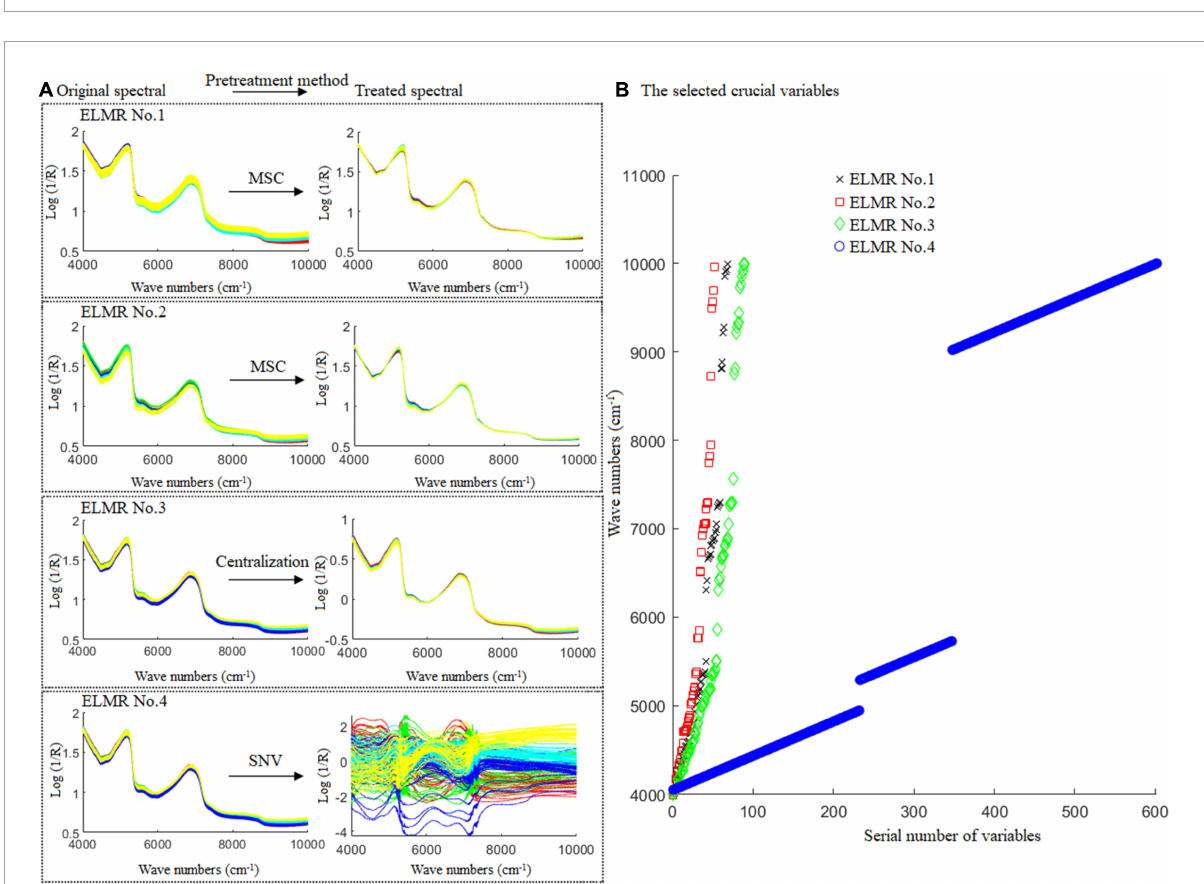
FIGURE7 The best pre-treatment technique and the crucial variables selected for the optimal ELMR models constructed. ELMR No. 1 for prediction of the CBG content in DBT adulterated with CBG; ELMR No. 2 for prediction of the PBG content in DBT adulterated with PBG; and ELMR Nos. 3 and 4 for prediction of the CBG and PBG content in the DBT ternary mixed with cow and pig blood-based gels,